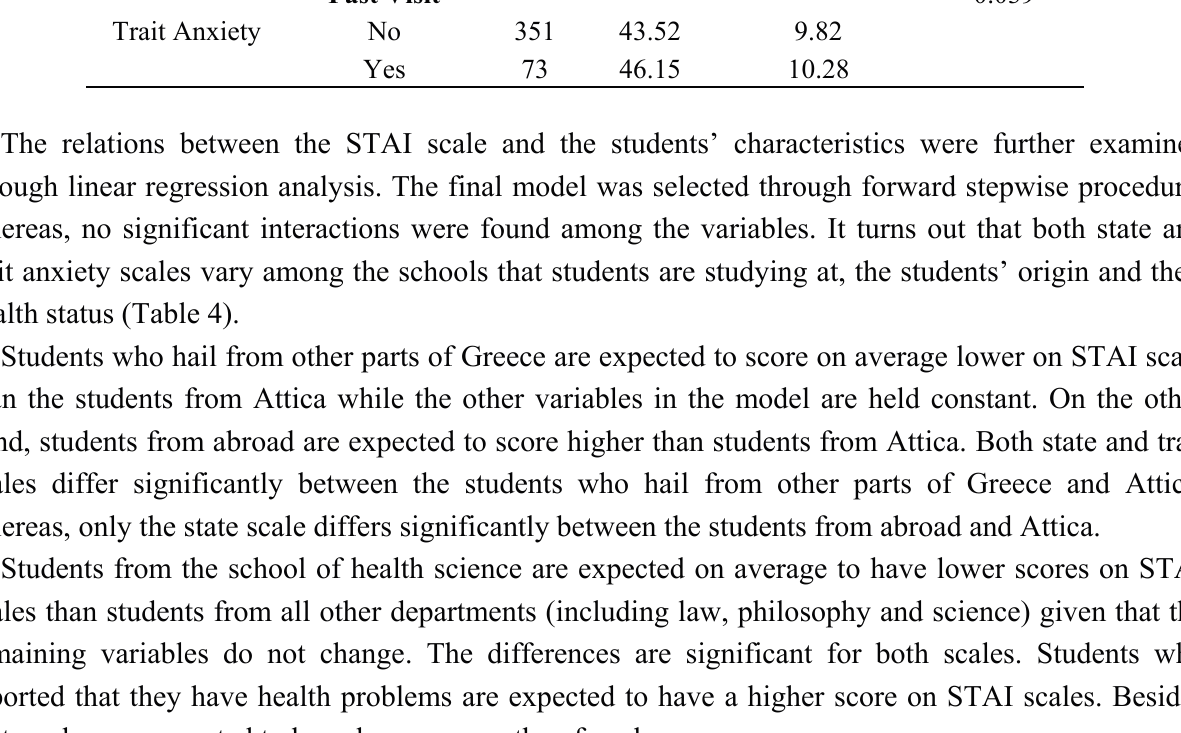
Table 3. T -test for State-Trait anxiety inventory (STAI) scales with family status and past visits. STAI n Mean Std. Deviation p -Value Family State Anxiety